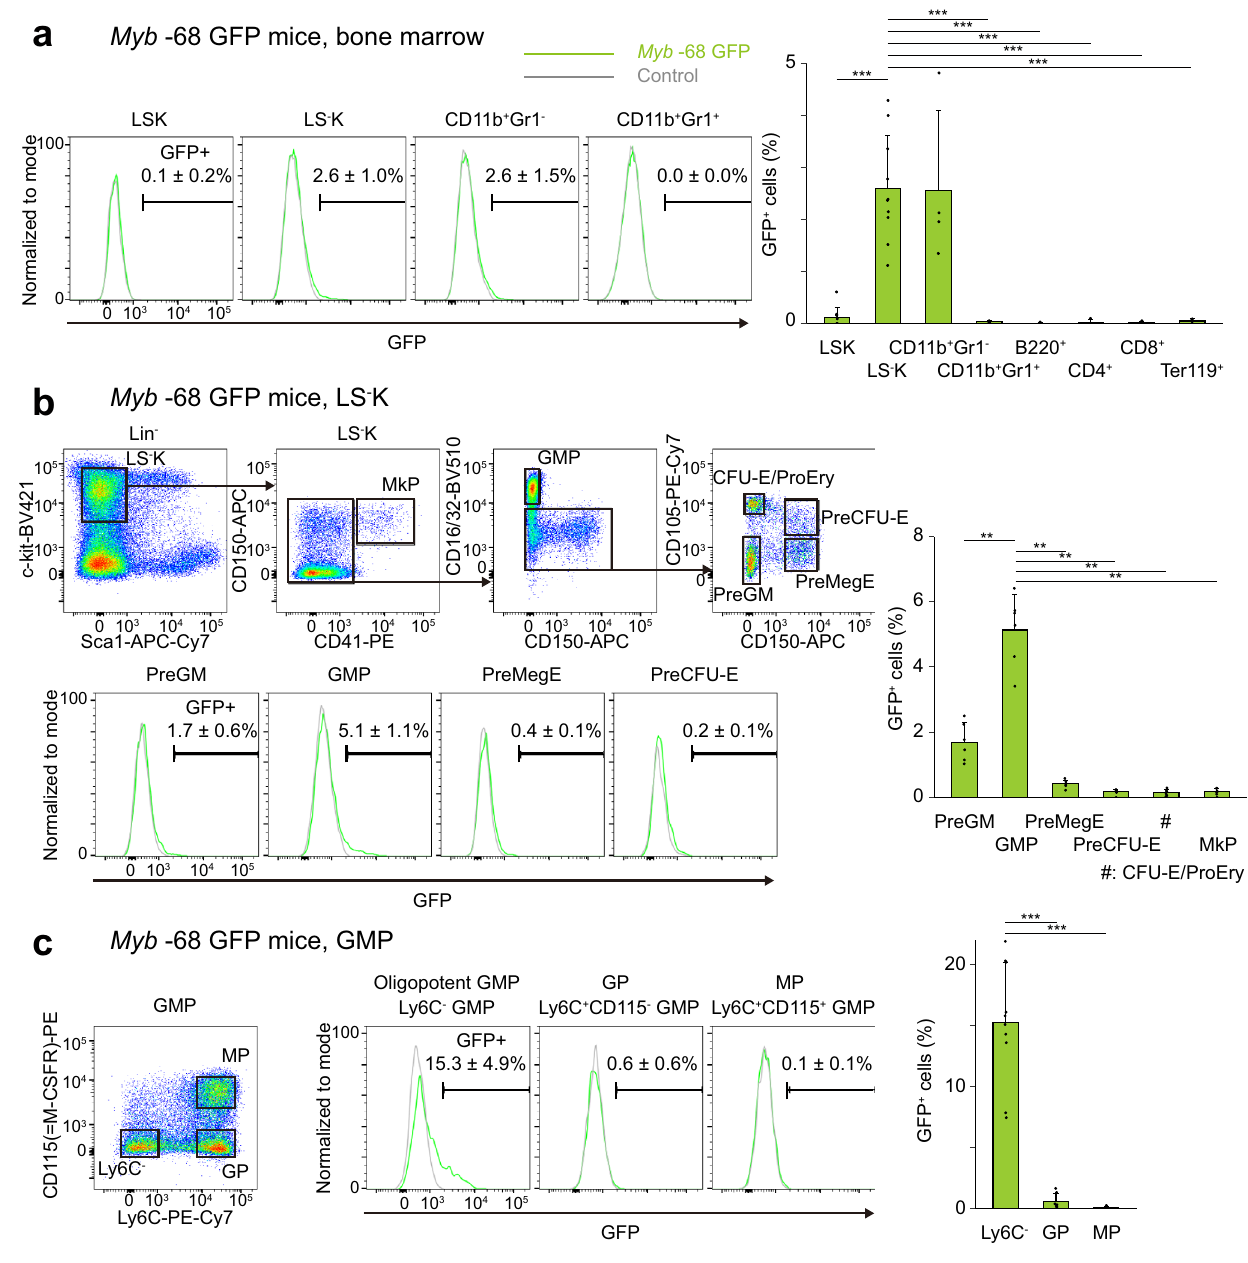
Fig.2|The Myb -68enhancerisactiveinLy6C - GMPsin Myb -68GFPtransgenic mice. GFP activity in whole bone marrow ( a ), LS - K cells ( b ), and GMPs ( c ) of Myb -68 GFP mice. FACS gating strategies are shown in Supplementary Fig. 12. Representative FACS plots of indicated cells from control (grey) and Myb -74 GFP mice (green) are shown. Numbers shown are mean percentages±SD of GFP + cells in Myb -68 GFP mice. The percentages of GFP + cells are also shown in the right graphs. a n =10 mice for LSK cells and LS - K cells, and n =4 mice for others. p =4.1×10 − 4 by one-way Welch ’ s ANOVA. *** p <0.001 by the Games-Howell post hoc test. p =4.1×10 − 4 between LSK and LS - K, p =3.7x10 − 4 between CD11b + Gr1 + andLS - K, p =3.5x10 − 4 betweenB220 + andLS - K, p =3.5x10 − 4 betweenCD4 + andLS - K, p =3.5x10 − 4 between CD8 + andLS - K, and p =3.9×10 − 4 between Ter119 +- and LS - K. ( b ) n =6 mice. p =5.8×10 − 7 by one-way Welch ’ s ANOVA. ** p <0.01 by the